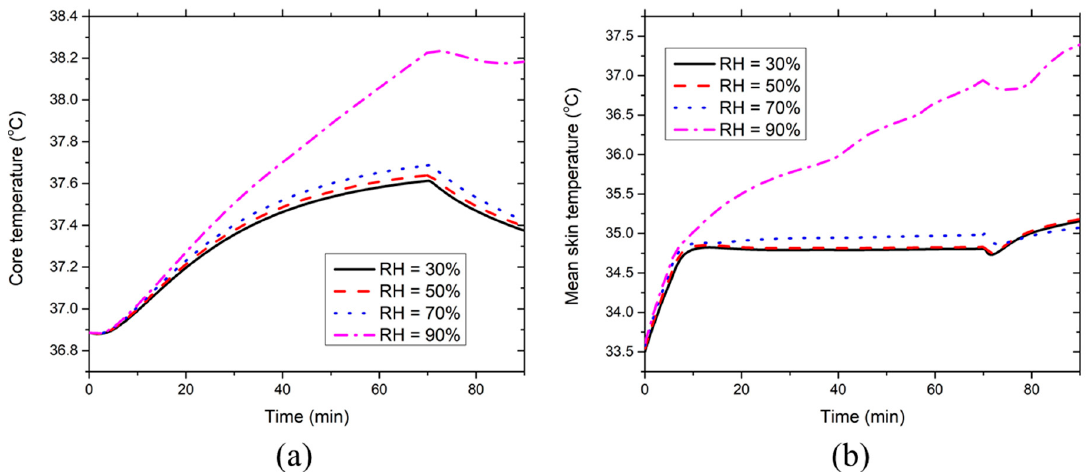
Figure 9. Effect of environmental RH on the time course of ( a ) core temperature and ( b ) mean skin temperature at the ambient temperature of 36 ℃ .